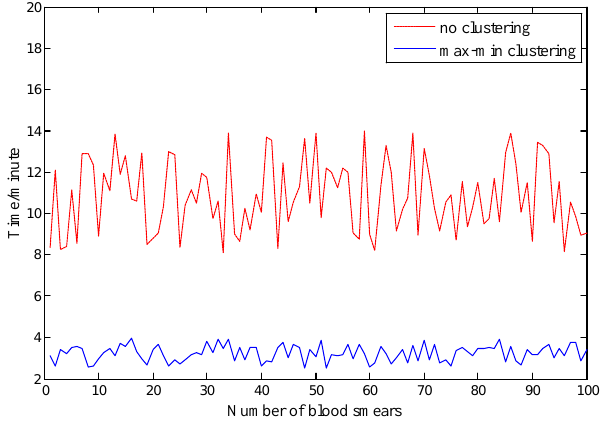
Fig. 7. Comparison of time